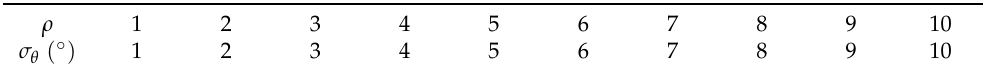
Table 4. Standard deviation σ θ against ρ in the first